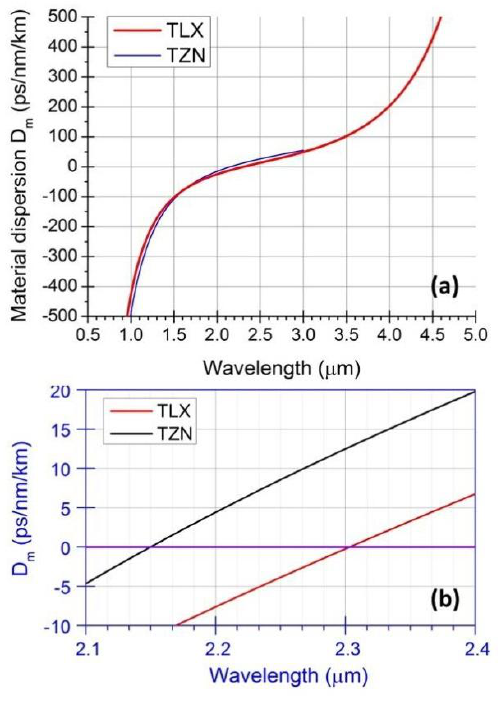
Figure 6. ( a ) Dispersion curves of TZN and TLX glasses; ( b ) Detailed curves of TZN and TLX near their zero material dispersion wavelengths.